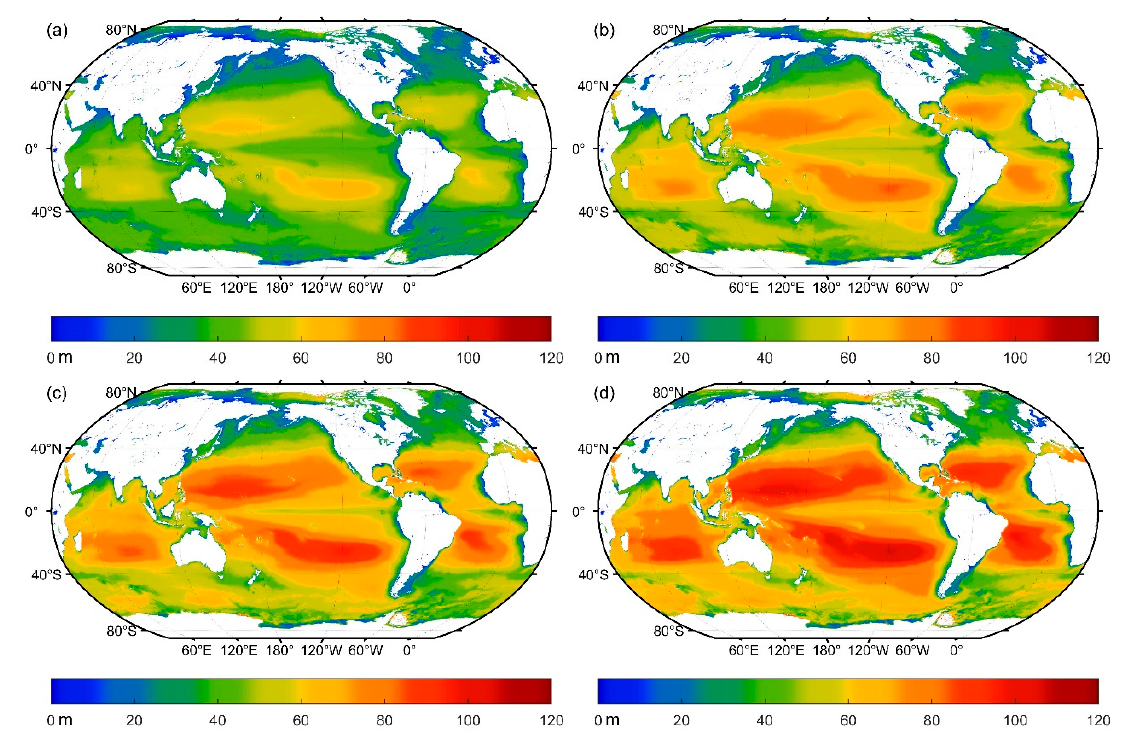
Figure 13. Global maximum detectable depths with different relative measurement errors including